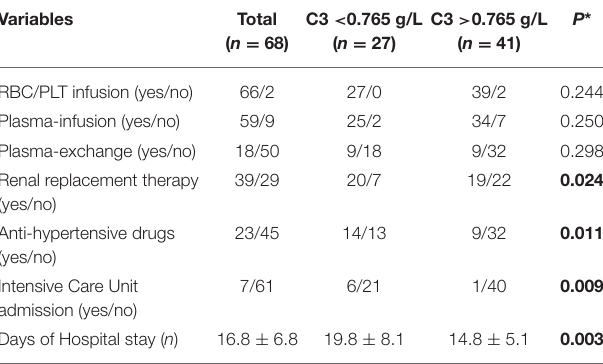
TABLE 4 | Clinical and laboratory characteristics of STEC-HUS patients with low vs. normal C3 serum levels at baseline.